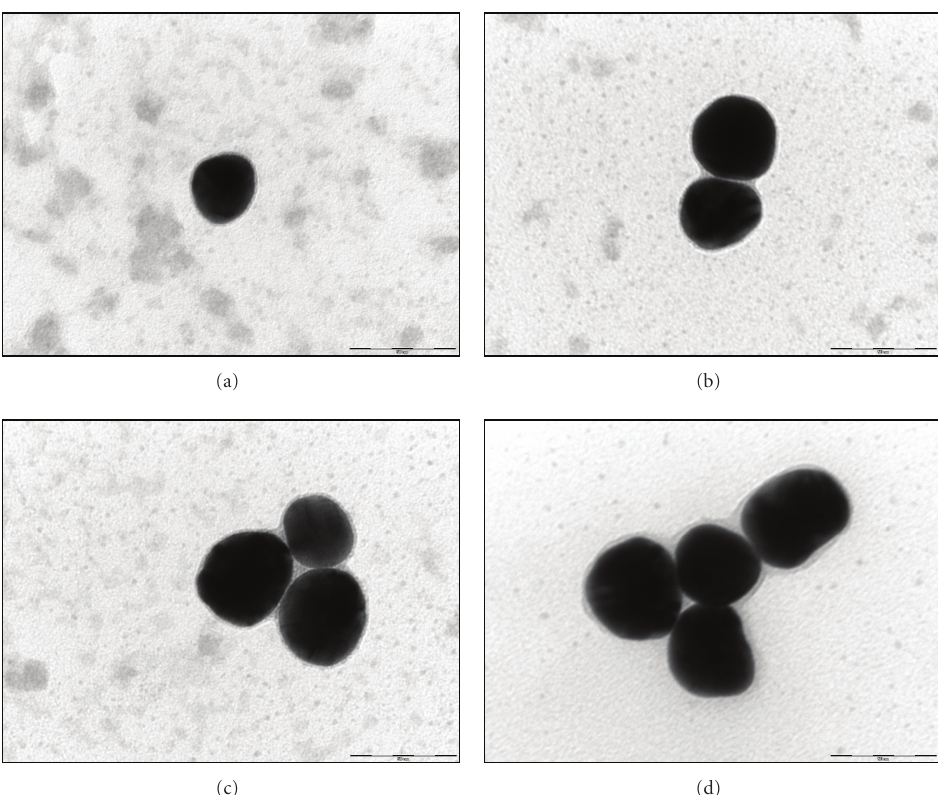
Figure 2: TEM images of single (a), dimer (b), trimer (c), and a small cluster of spherical gold nanoparticles. Scale bar